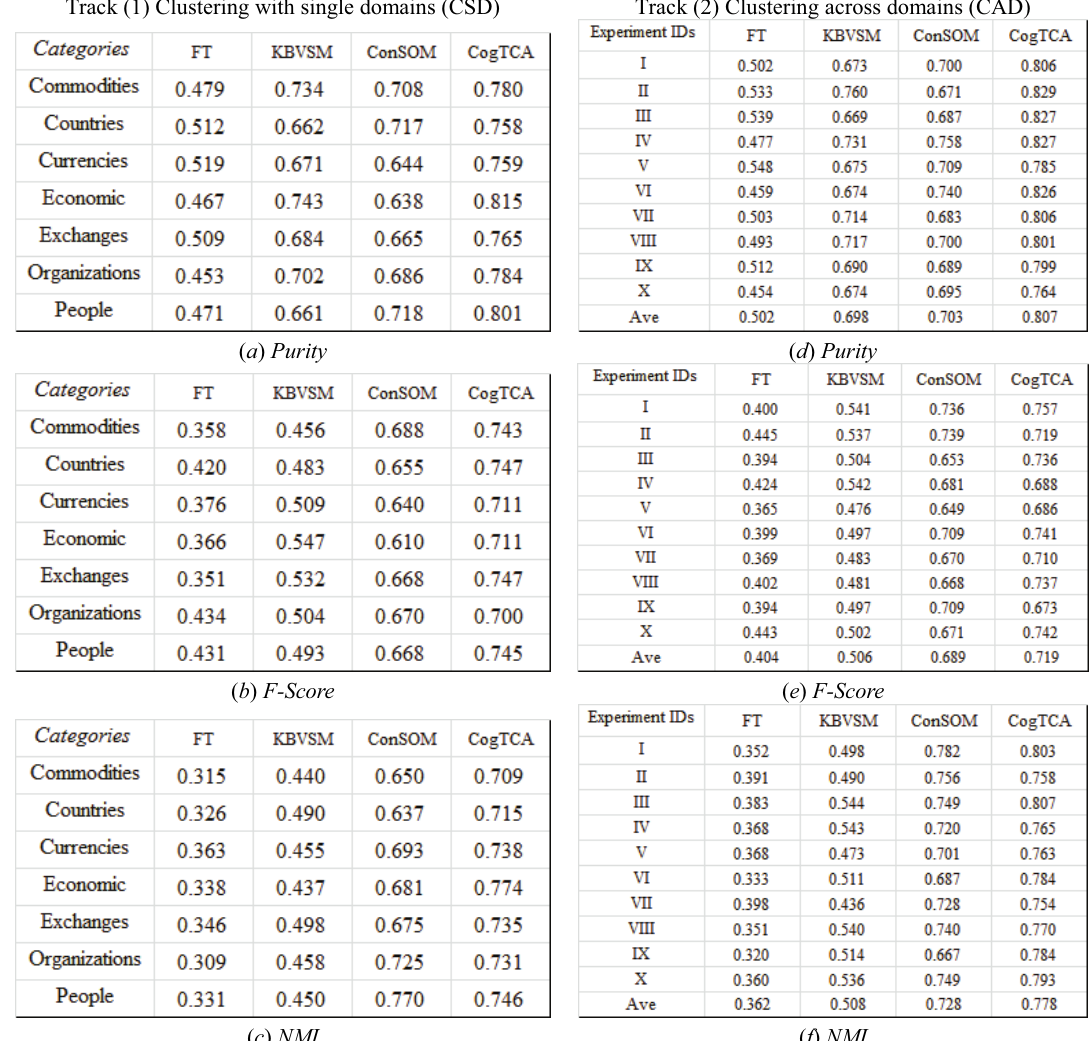
Fig.B.1 Experimental results of CSD and